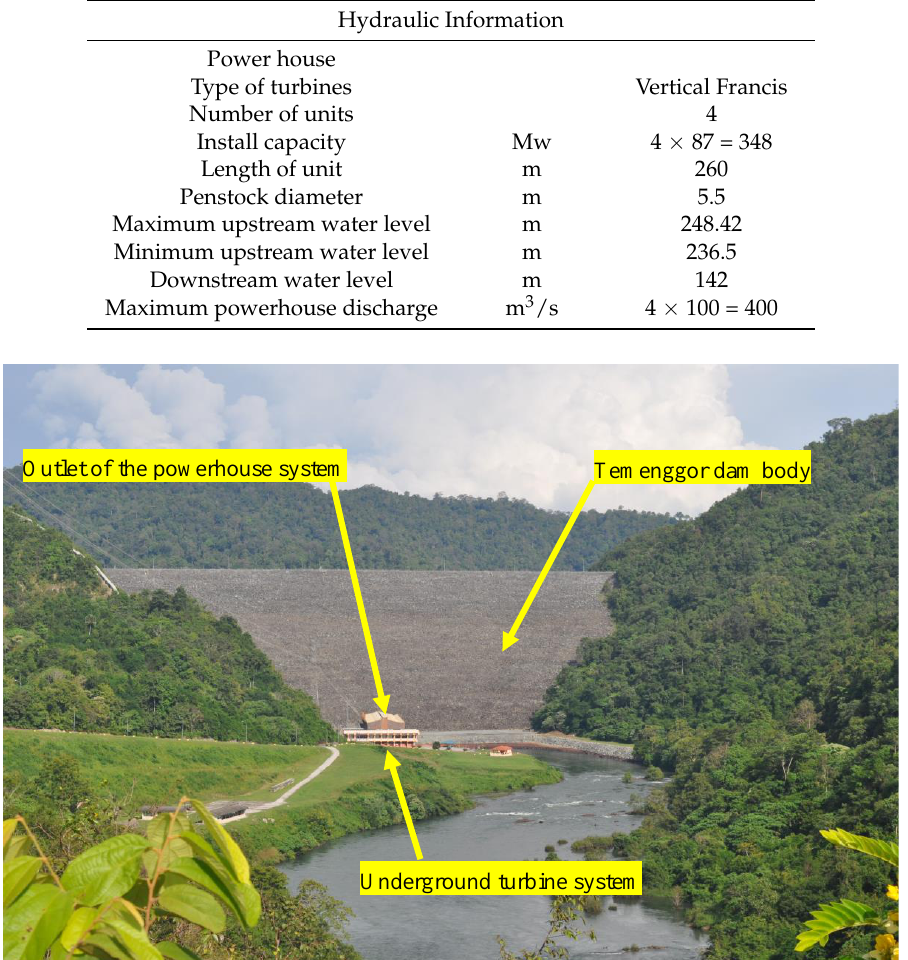
Figure 1. Top view of the Temenggor dam with surface powerhouse.